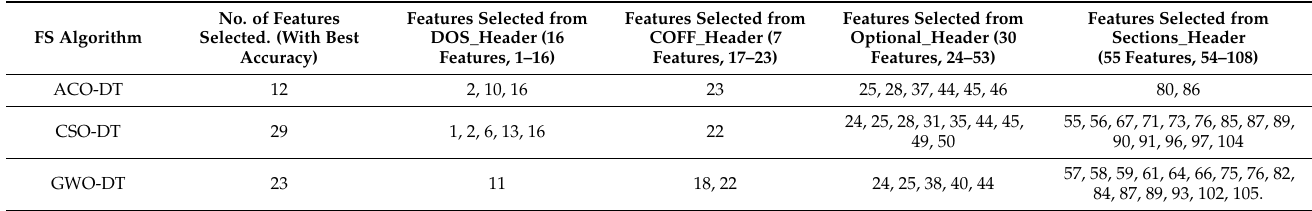
Table 15. Details of features selected in Run 4 of Table 14.